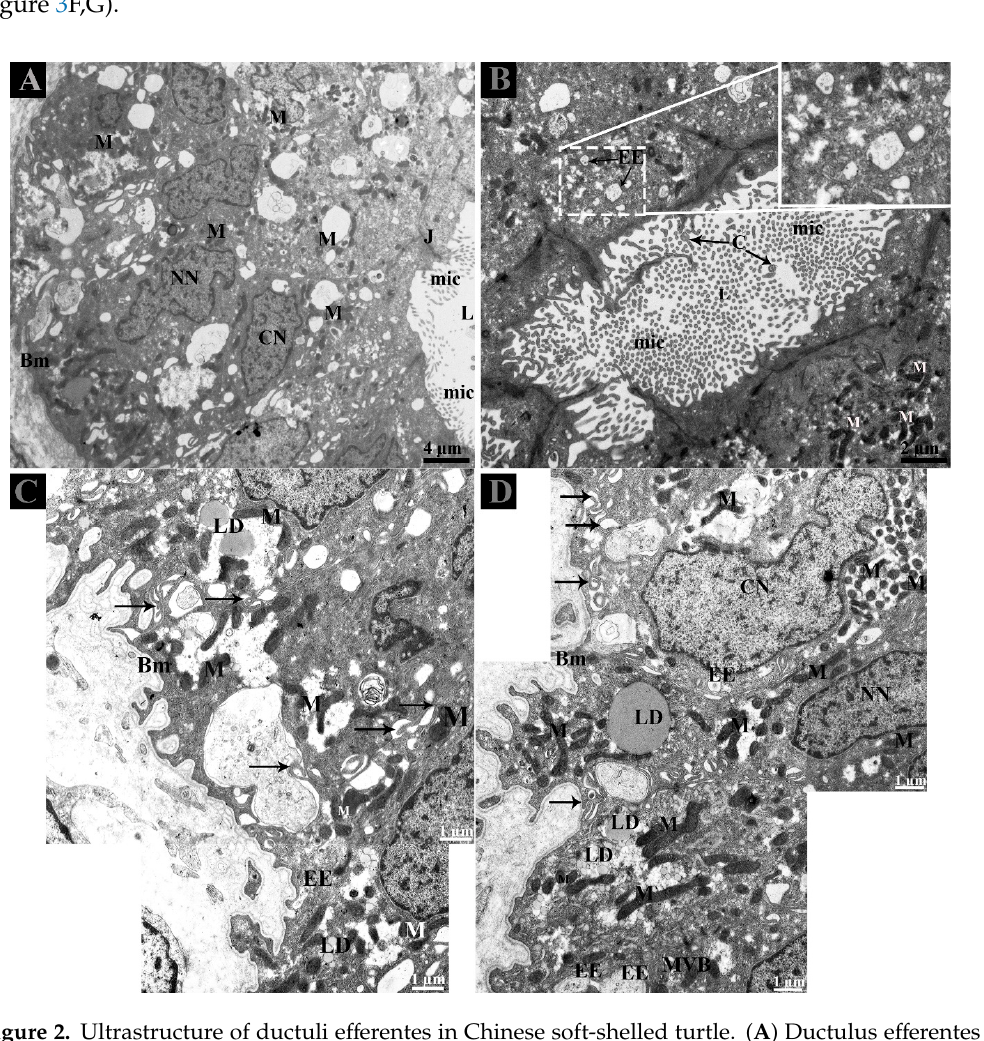
Figure 2. Ultrastructure of ductuli e ff erentes in Chinese soft-shelled turtle. ( A ) Ductulus e ff erentes comprises ciliated and non-ciliated cells and ( B ) lumen shows various microvilli and cilia. ( C , D ) At the basal membrane, early endosomes and multivesicular bodies were present adjacent to the lipid droplets and interdigitations (black arrow). BM: basement membrane; C: cilia; CN: ciliated cells nuclei; EE: early endosome; L: lumen; LD; lipid droplet; M: mitochondria; Mic: microvilli; MVB; multivesicular body; NN: non-ciliated cells nuclei. Scale bar: A: 4 µ m; B: 2 µ m; C–D: 1 µ